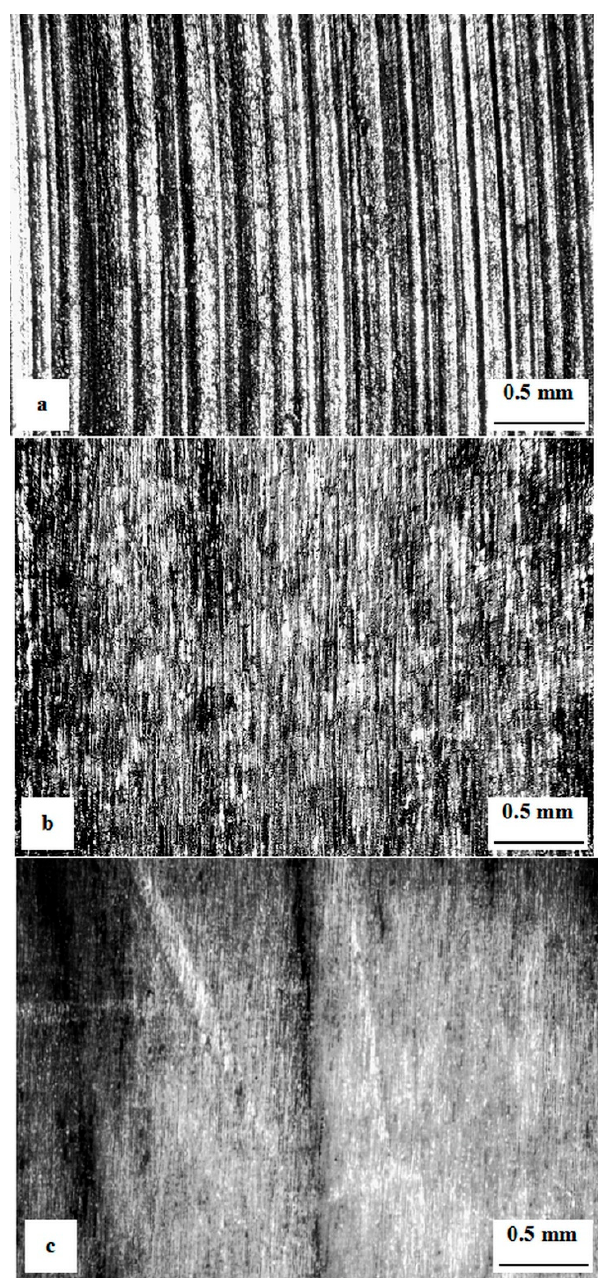
Figure 3. Plan-view optical micrograph showing the surfaces of specimens made of Vanadis 6 steel with different roughness: ( a ) Milled, ( b ) fine ground, and ( c ) polished. Adapted from the corresponding literature [45]. (Copyright, Materials Engineering/Materiálové inžinierstvo, 2011).